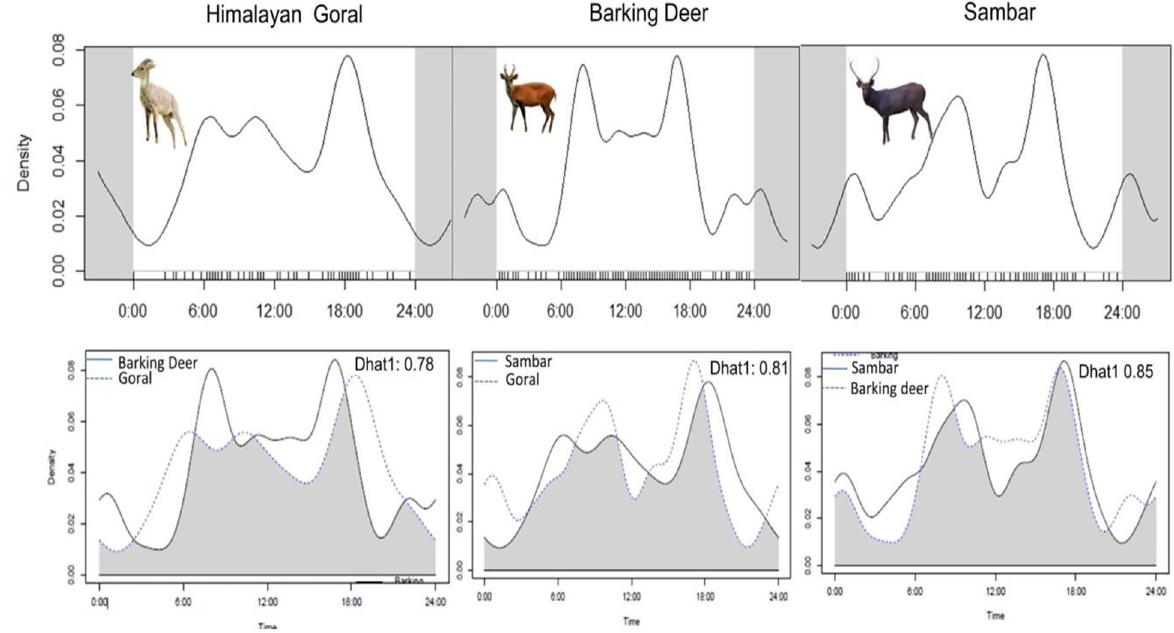
Figure 2. Temporal activity pattern of three ungulate species (goral, barking deer and sambar—top row) and overlapping activity pattern of barking deer-goral, Goral-sambar, and sambar-barking deer (Bottom row). Overlap package of R-Software (R.3.4.3, https:// www.R- proje ct. org) was used to create the